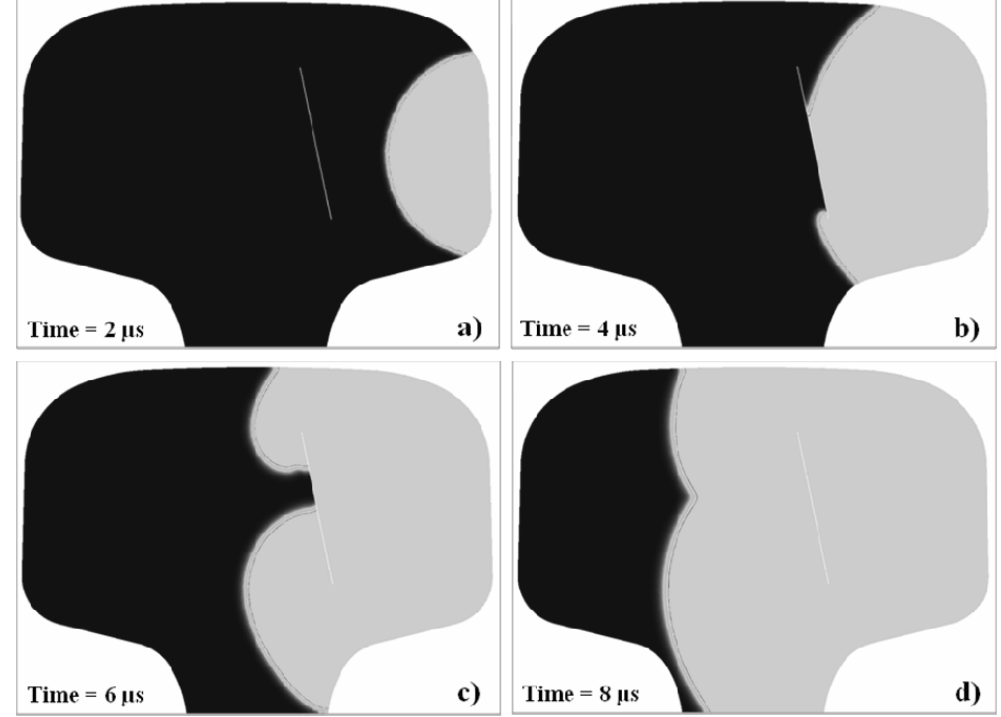
Figura 12: Mappa degli spostamenti in quattro istanti differenti dal modello agli elementi finiti per lo studio del fungo senza difetti. Le